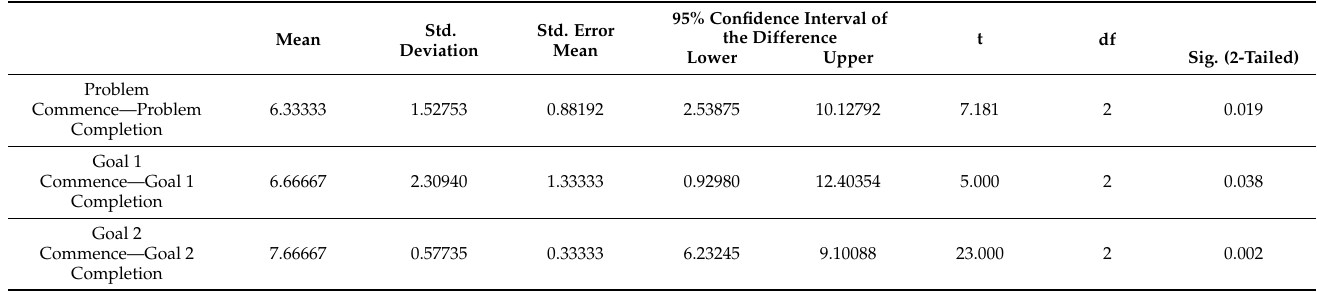
Table 2. Problem and Goals Statements paired samples test—Commencement to